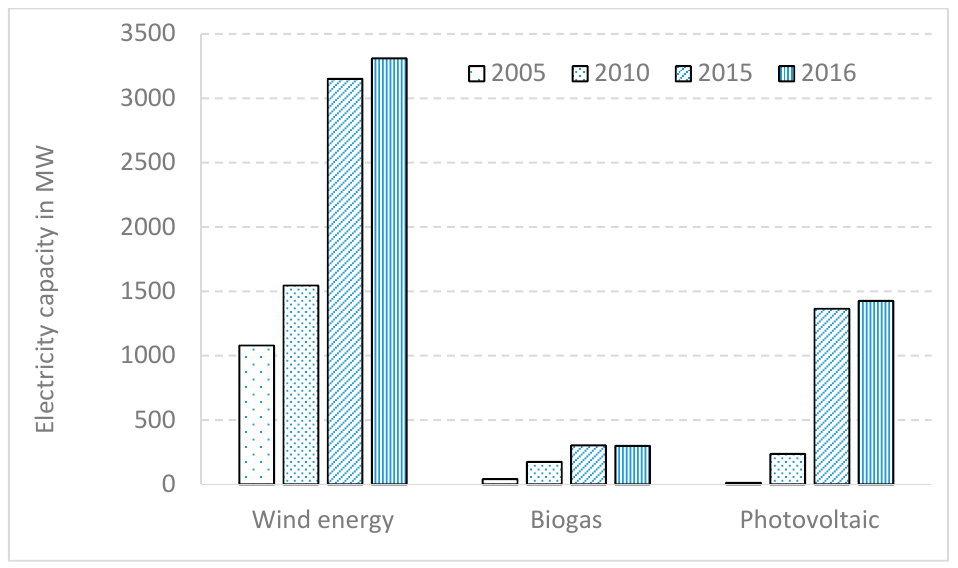
Figure 2. Development of electricity generation from renewable energies in the federal state of Mecklenburg-Western Pomerania [8].